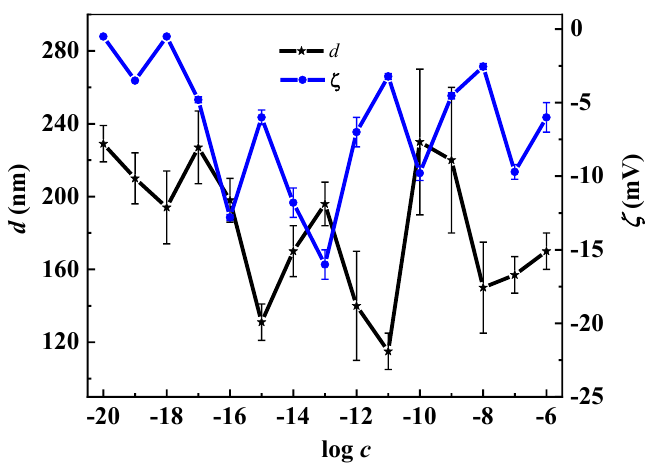
Figure 2. Dependence of the size of particles (d) and ζ -potential ( ζ ) on the concentration (c, mol/L) of the L -Trp systems, 25 °C.